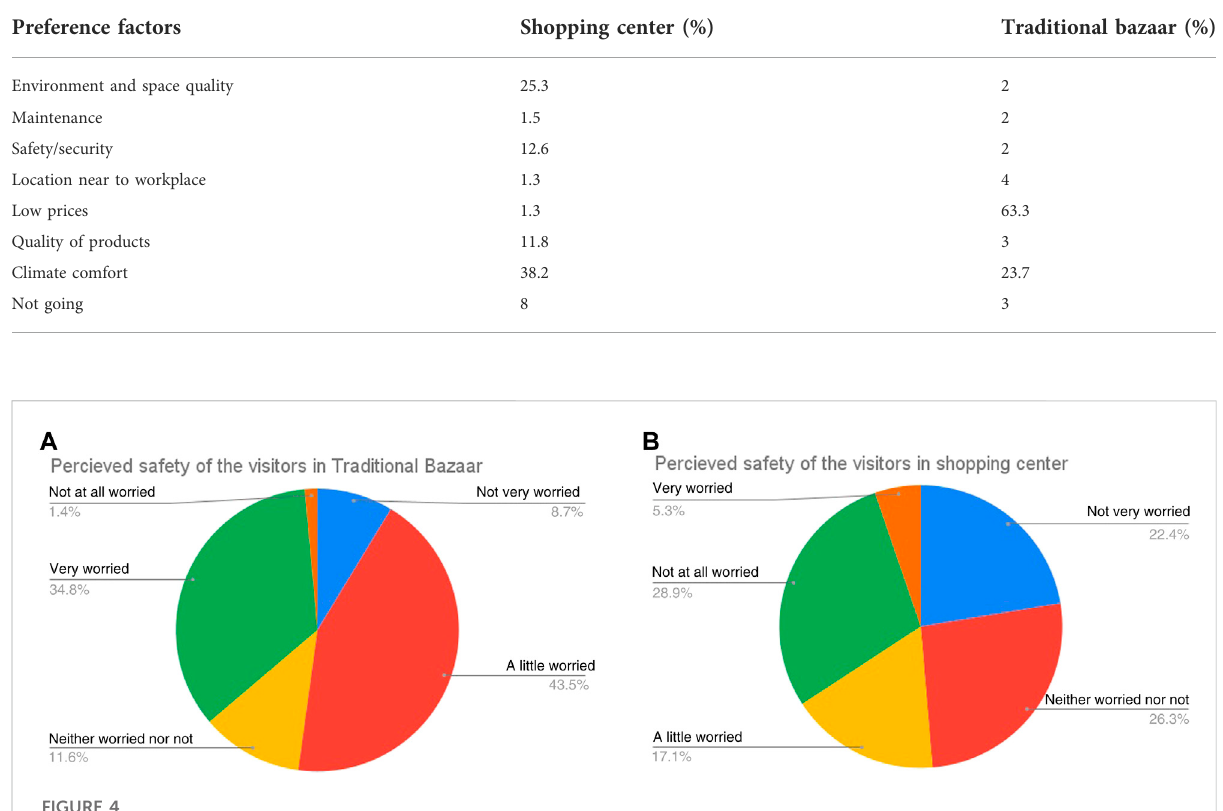
FIGURE 4 (A) Perceived safety of the visitors in Traditional Bazaar (N = 76). Source: Authors, 2022. (B) Perceived safety of the visitors in shopping center (N = 76). Source: Authors,